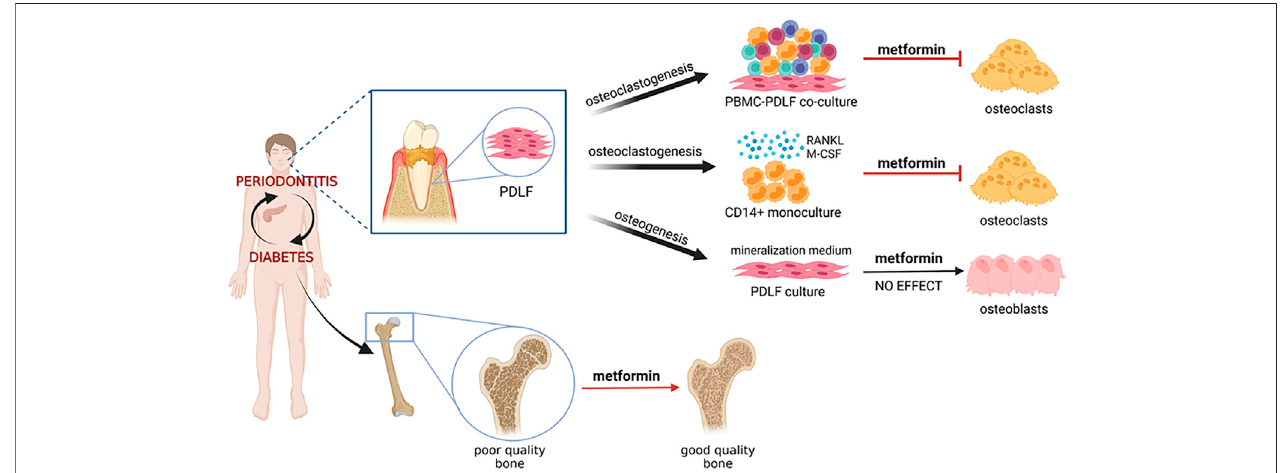
FIGURE6| Graphicalabstract.Diabetesandperiodontitisareclinicallyassociated.Mouseexperimentalperiodontitismodelasandpreliminaryclinicalstudiesshow that diabetes drug metformin has bene fi cial effects on the periodontium, the tooth associated tissues including bone. This study has analyzedthe effectof metformin on clinically relevant cell models: periodontalligament derived fi broblasts(PDLF)that were either steered into osteogenesis pathways or into osteoclastogenesis pathways, together with peripheral blood monocnuclear cells (PBMCs) under continual exposure to metformin. The effect of metformin on osteoclast formation was further assessed with CD14 + monocytes that were subjectedto osteoclast differentiation with osteoclastogenesis driving cytokines M-CSF and RANKL. Our results all indicate an inhibitory effect on osteoclast formation, which could, in a broader sense, be the mechanism that explains clinically observed bone improvement in metformin users.